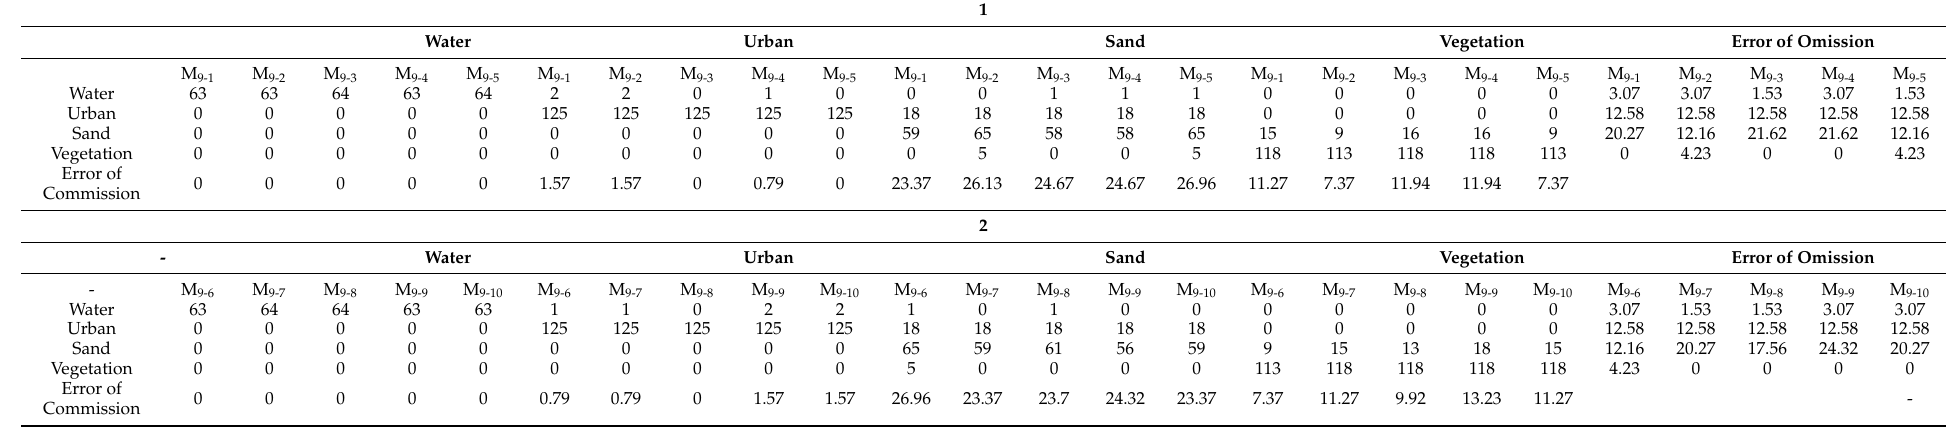
Table 5. 1. Confusion matrix of testing data of one-to-five-fold cross-validation. 2. Confusion matrix of testing data of five-to-ten-fold